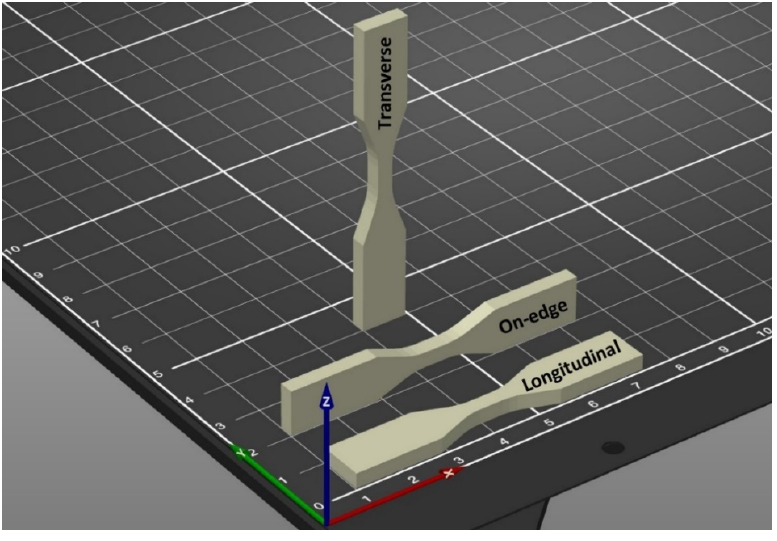
Figure 13. Build orientation modes.